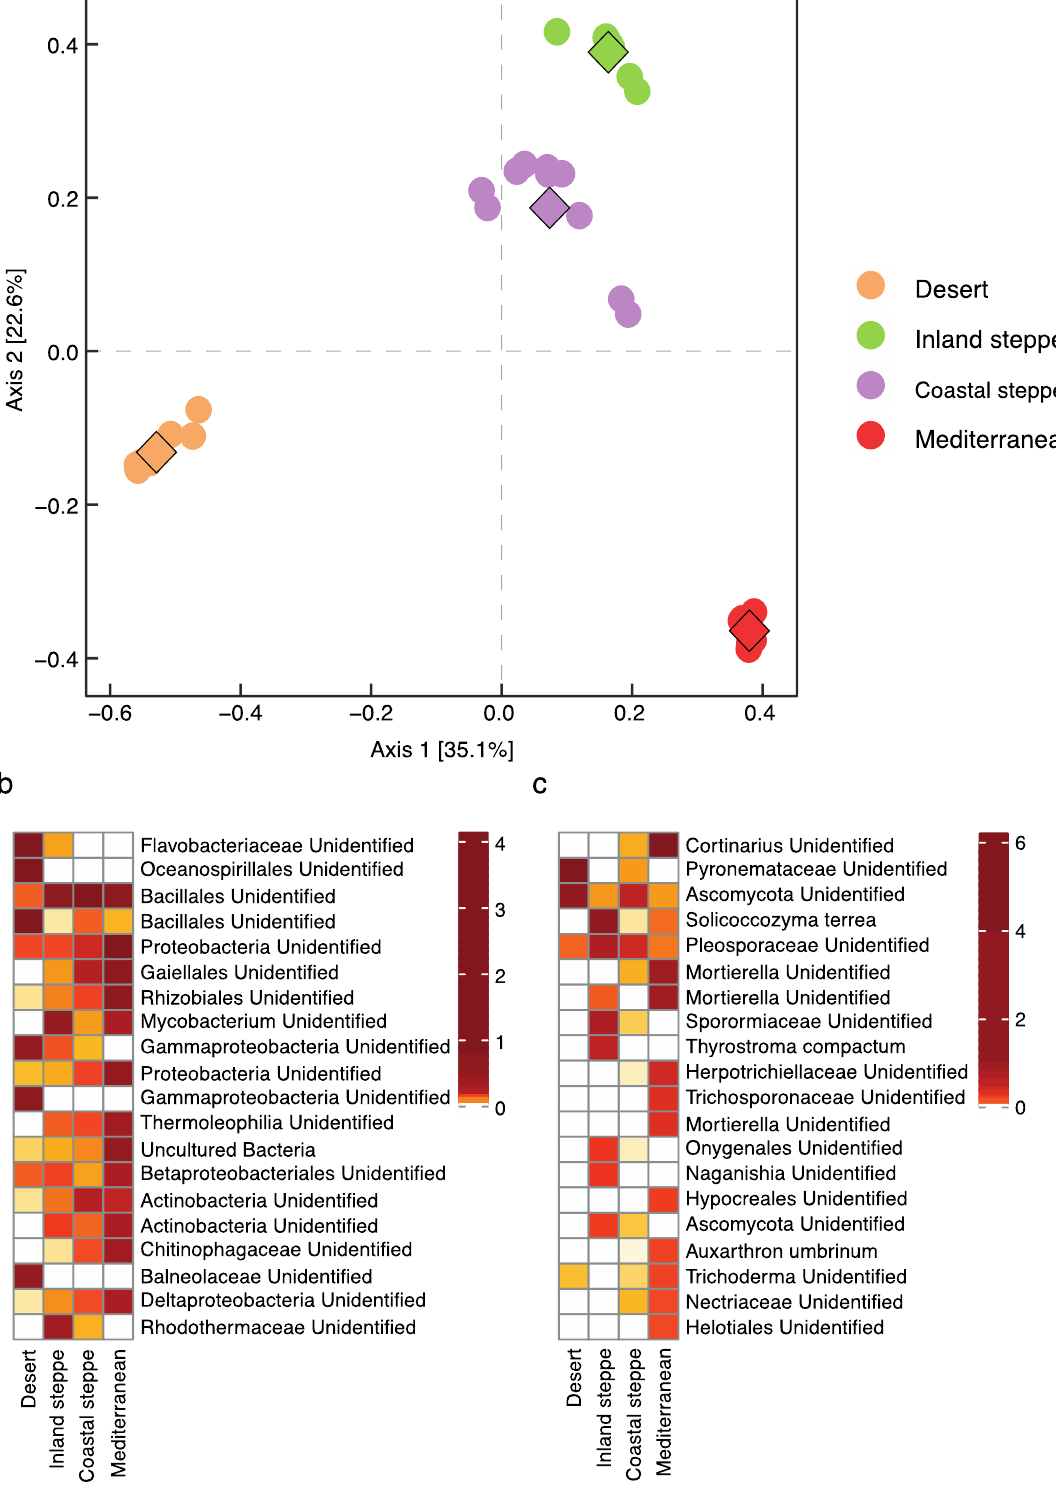
Figure 4. Principal coordinate analysis (PCoA) of the microbial community composition of soil samples ( a ). Diamonds correspond to the group centroid. Heatmaps showing the top 20 bacterial ( b ) and fungal ( c ) ASVs that drove the community differences. Color scale was grouped by quintiles for visualization purposes. See Table S4 for dissimilarity analysis and Table S5 for full microbial community.